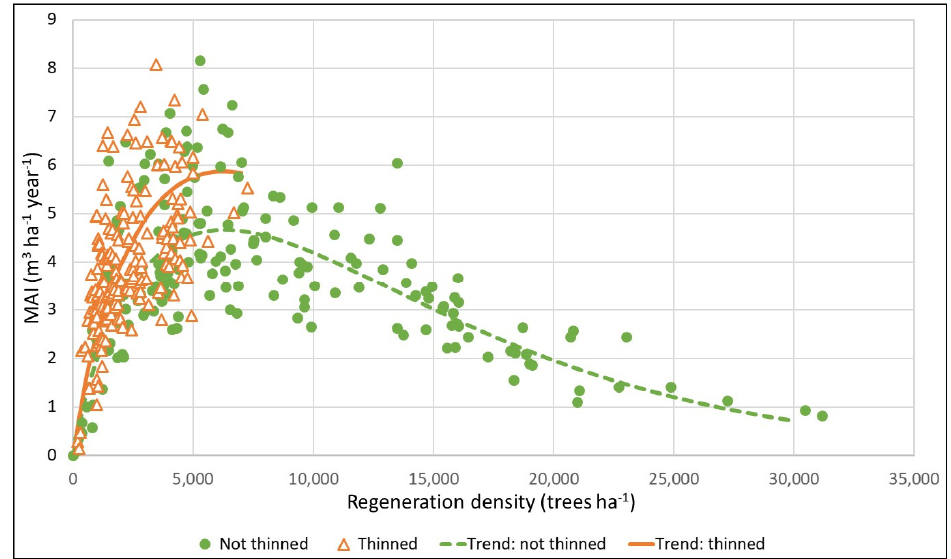
Figure 4. Trend of projected maximum merchantable MAI with density of regeneration. MAI at culmination age (X) is displayed against density of lodgepole pine 17 growing seasons after planting (Y). Data points for individual plots are shown relative to trend lines based on the equation: Ln Y =